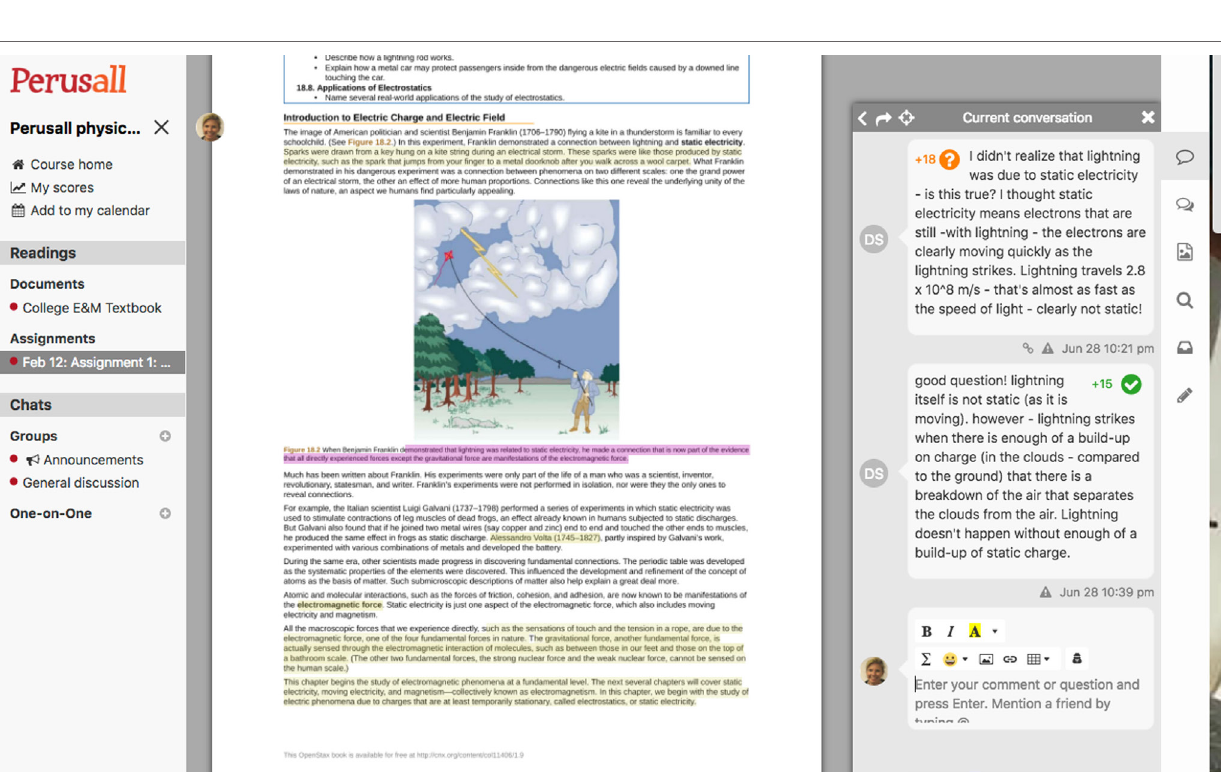
FigUre 3 | Reading assignment in Perusall showing student highlights and annotations (note: the depicted individual provided written informed consent for the publication of their identifiable image, the image of the textbook book is from OpenStax, University Physics, Volume 1. “Download for free at https://openstax.org/ details/books/university-physics-volume-1,” no further permission is required from the copyright holders for the reproduction of this material).